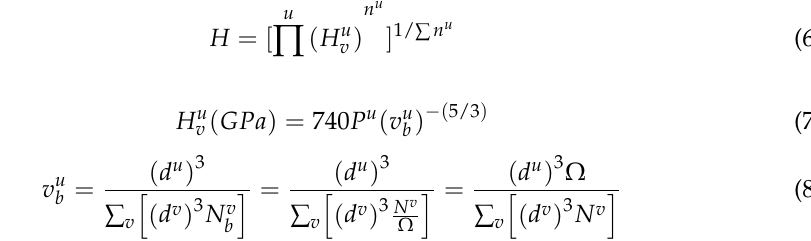
Figure 9. The values of ( a ) B , ( b ) G and ( c ) E of Cr 7 C 3 , Cr 3 C 2 and Cr 23 C 6 under applied pressure. The overlap population of each atom is shown in Table 3. The difference of atomic and C atoms. Total refers to the total electron number after the gains and losses; Charge refers to the gains and losses in electron number, where negative value indicates the elec-